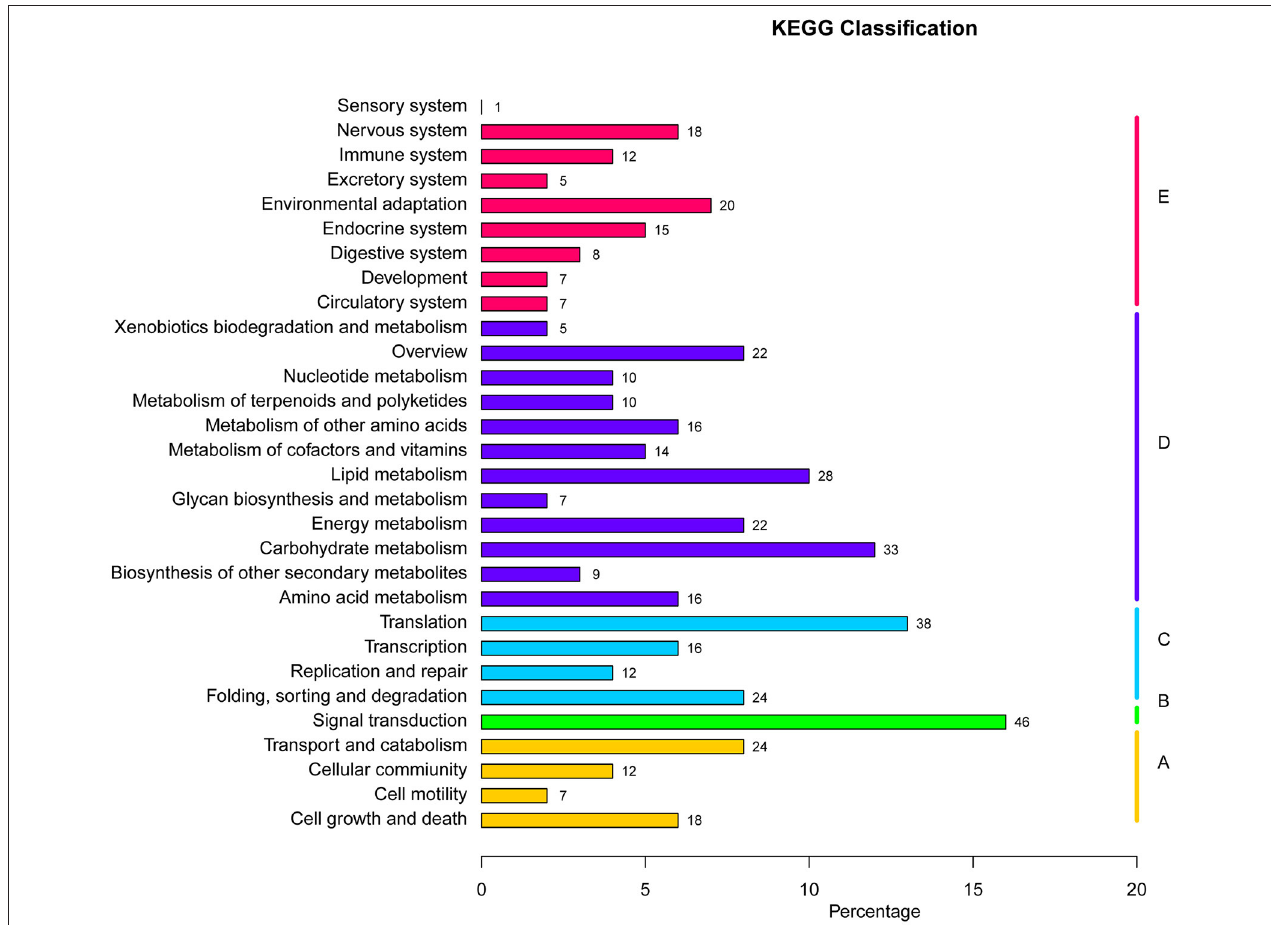
FIGURE 7 | KEGG pathways enrichment analysis in highly differentiated regions between P. davidiana and P. alba